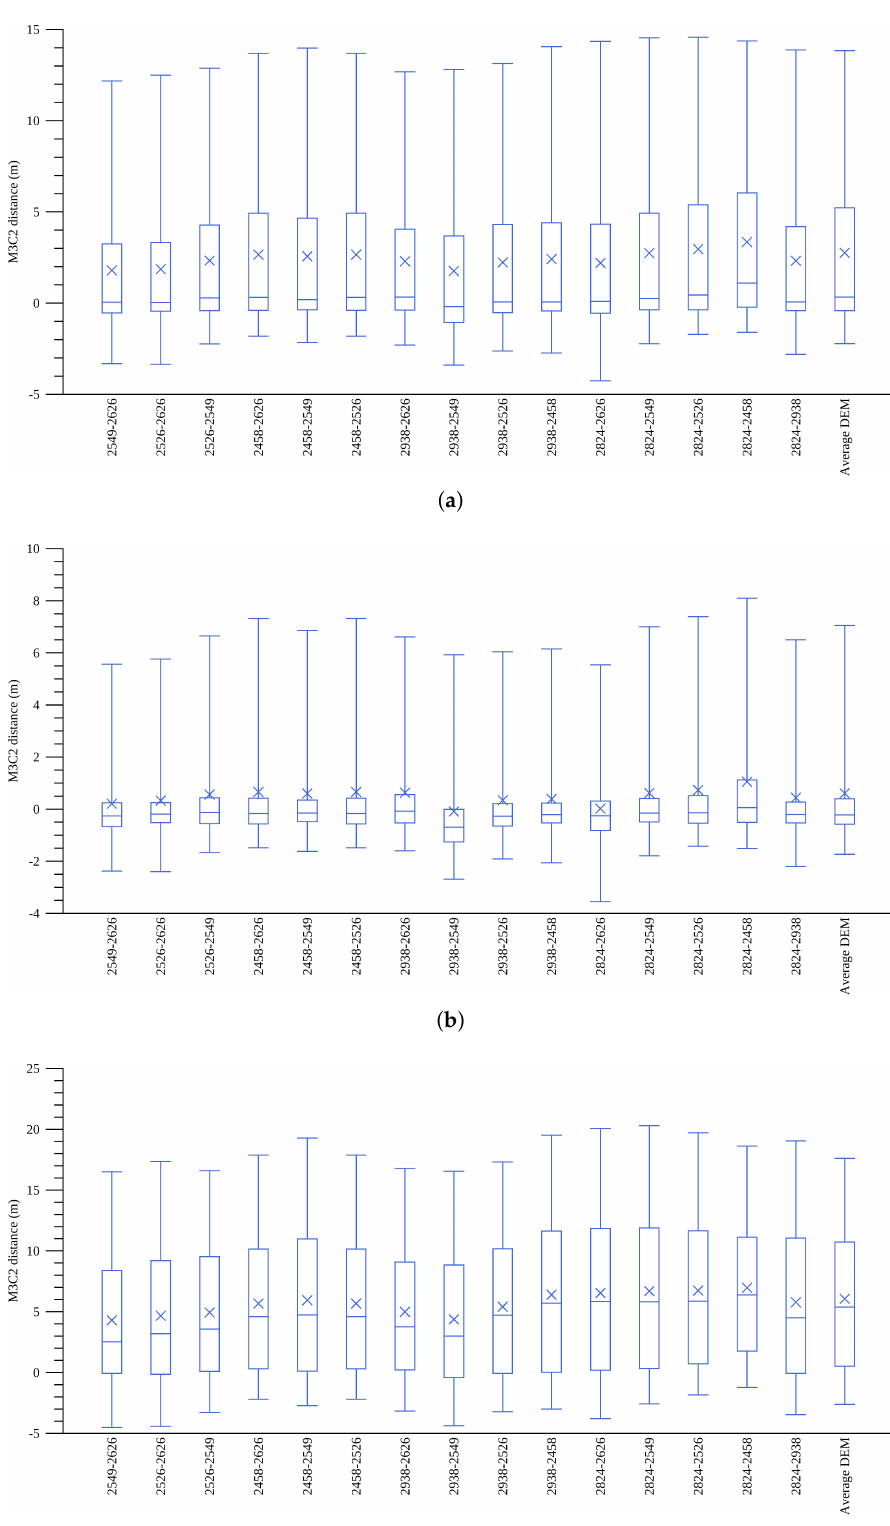
Figure 8. Statistics on M3C2 distance in the Centre area for all the computed DEMs, using LiDAR data as reference. Box limits are the first and third quartiles, while the band inside is the median. Whiskers represent the 5th and 95th percentiles. Crosses represent means. ( a ) statistics on the whole area; ( b ) on roof surfaces; ( c ) on carriageway surfaces. Values are reported in the Supplementary